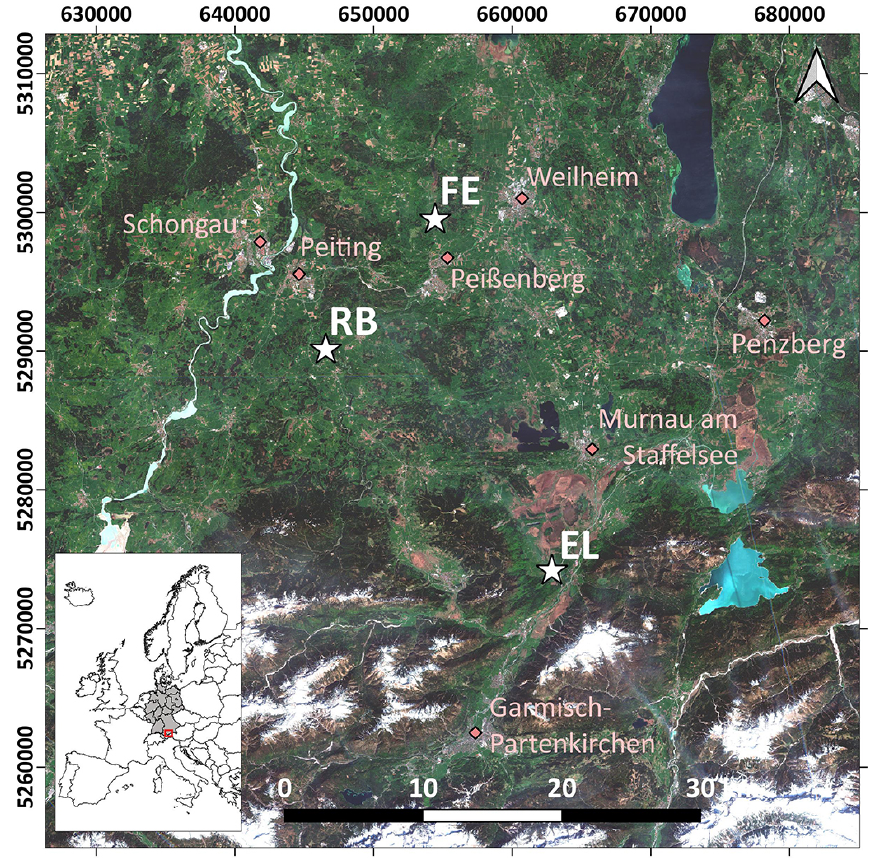
Figure 1. Location of the three study sites (white stars) in the study area in the south of Germany. EL: Eschenlohe, FE: Fendt, RB: Rottenbuch. Major towns are indicated for reference (pink diamonds). Background: true-colour composite of Sentinel-2B images from 27 April 2018 (contains modified Copernicus Sentinel data from 2018, processed by ESA). Coordinate reference system used is